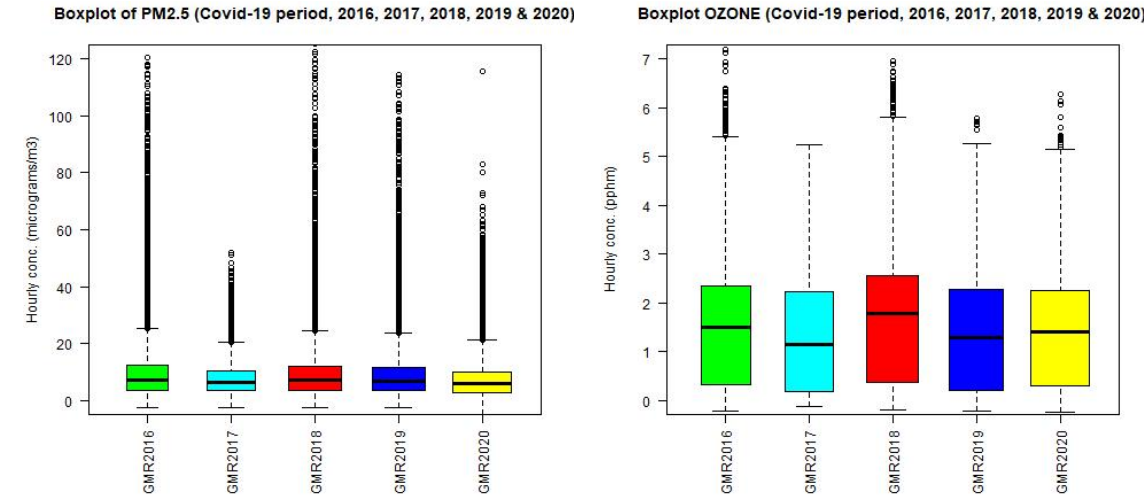
Figure 6. Boxplot of NO 2 , CO, PM 2.5 , and O 3 for the period from April to June in 2017, 2018, 2019, and 2020 over all the sites in the GMR. Table 3. Summary statistics of NO 2 , CO, PM 2.5 , and O 3 for the period from April to June in 2017, 2018, 2019, and 2020.